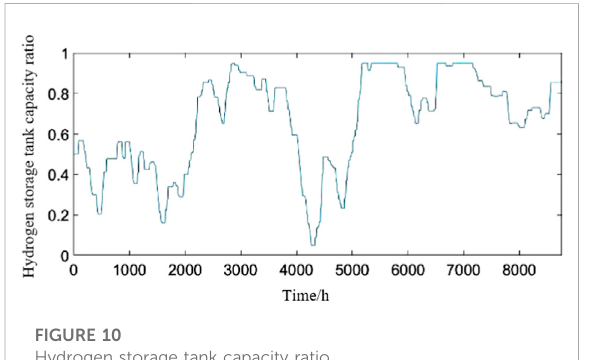
FIGURE 10 Hydrogen storage tank capacity ratio.